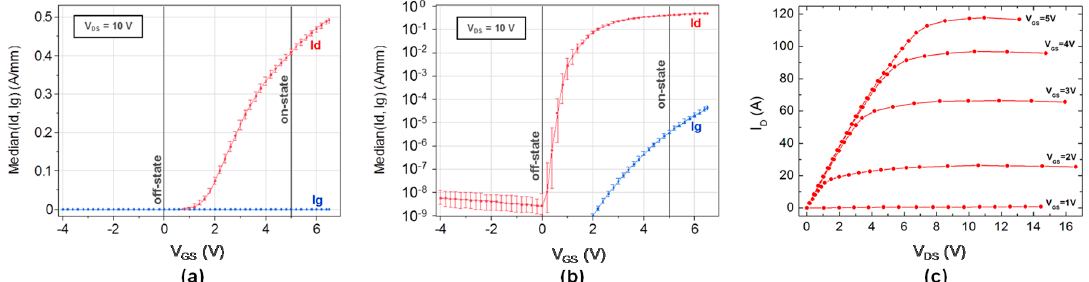
Figure 4. Current-Voltage (IV) characteristics of p-GaN gate HFETs: Transfer characteristics (drain current in red and gate current in blue) for 600 V p-GaN gate HFETs in ( a ) linear and ( b ) logarithmic scale. Wafer statistics from 36 devices are shown. Device gate width is 3.2 mm; ( c ) Output characteristics of a 60 m Ω /600 V p-GaN gate HFET with 214 mm gate width.